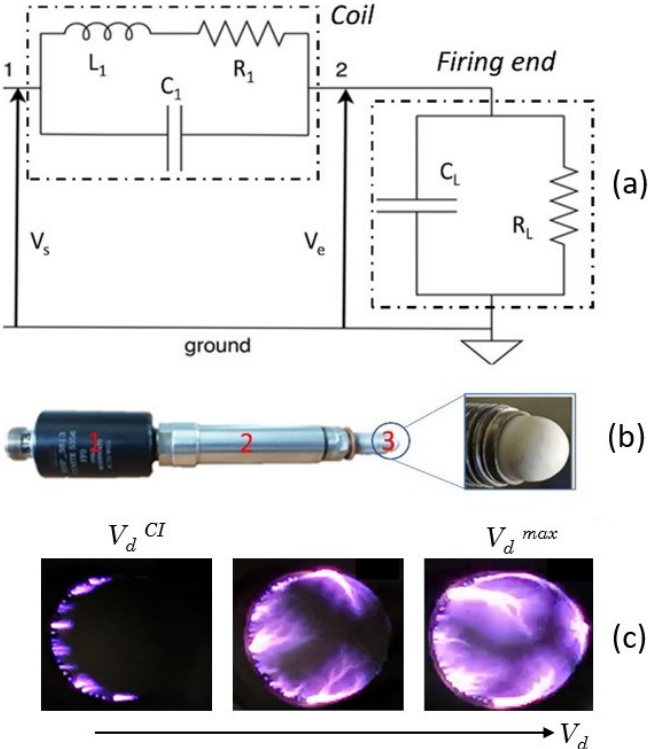
Figure 1. ( a ) 1: inductor, 2: connection, 3: firing end of the igniter and corresponding detail of the firing end. ( b ) BDI lumped-parameter circuit. The coil is represented by an inductive component L 1 , a resistance R 1 which takes into account skin and proximity effects losses and ohmic losses, and a parasitic capacitance C 1 between the turns. The firing end mostly represents the capacitance C L of the igniter assembly. A resistance R L , in parallel, is introduced to account for the ohmic losses of air and bulk insulation. ( c ) Streamers development around the BDI cupola as driving voltage increases from the inception up to the maximum allowed voltage.